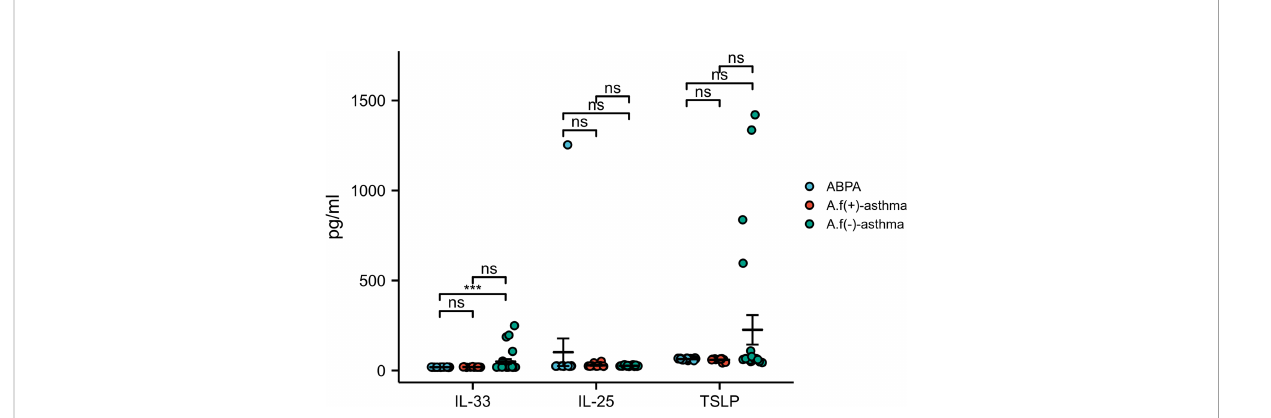
FIGURE 4 Correlation of clinical parameters in the three groups. ACT, asthma control test; A.f , Aspergillus fumigatus ; BMI, body mass index; tIgE, total IgE; FVC, forced vital capacity; FEV1, forced expiratory volume in 1 s; PEF, peak expiratory fl ow; MMEF, maximum mid-expiratory fl ow; MEF50: maximal expiratory fl ow 50; MEF25, maximal expiratory fl ow 25; FeNO, fractional exhaled nitric oxide; SNEUT, sputum neutrophils; SMø, sputum macrophages; SEO, sputum eosinophils; SLY, sputum lymphocytes; WBC, white blood cell; NEUT, neutrophils; LY, lymphocytes; EO, eosinophils; ESR, erythrocyte sedimentation rate; PCT, procalcitonin. ***p < 0.001; ns indicates no statistical signi fi